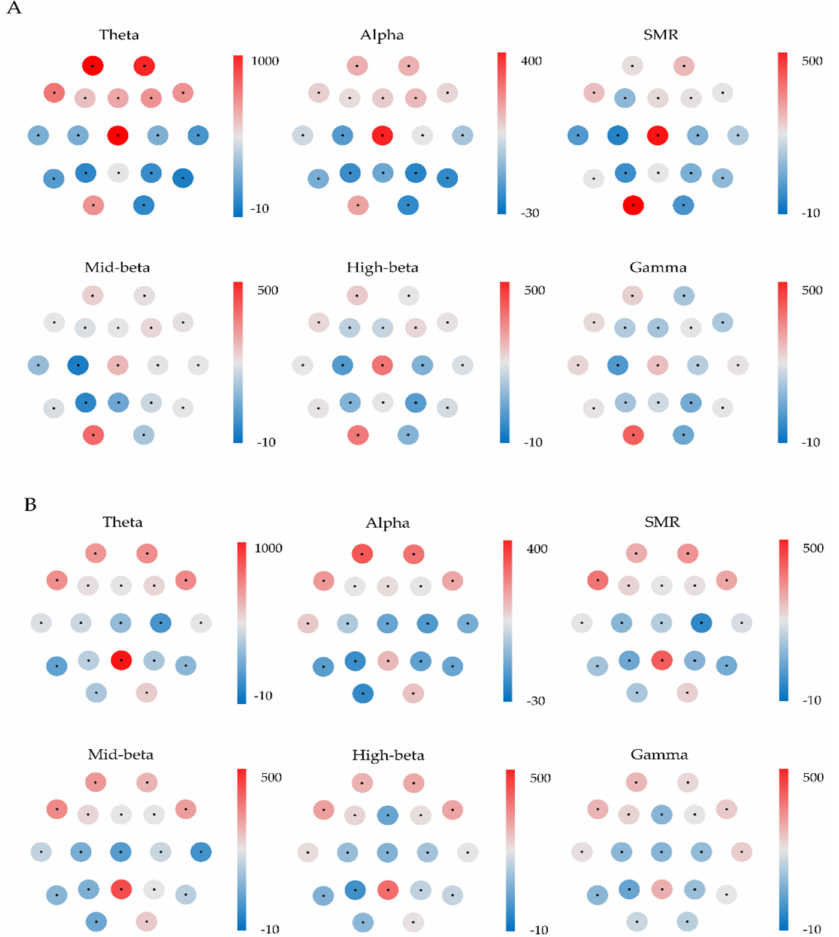
Figure 5. Electrode usage of six electroencephalography (EEG) subgroups is indicated by the red and blue of the circle around each electrode location at ( A ): T-3 3100 Hz, ( B ): T-3 520 Hz that showed significant differences in psychoacoustic